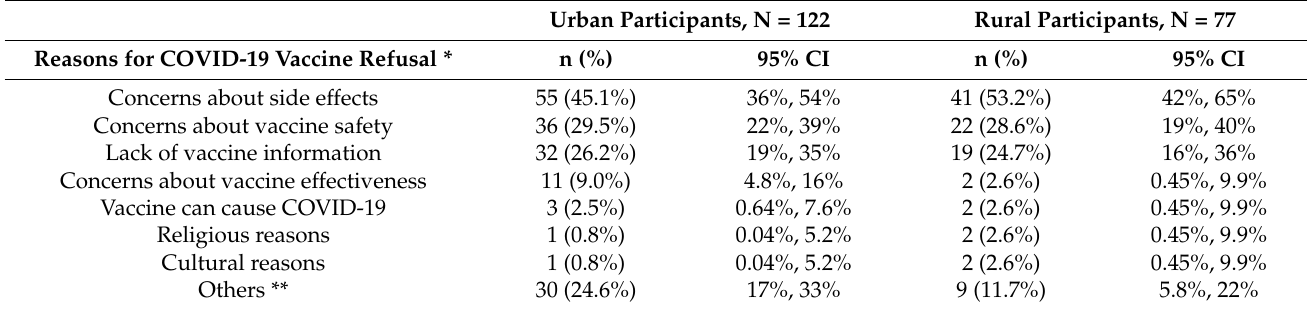
Table 4. Reasons for vaccine refusal among those not vaccinated.